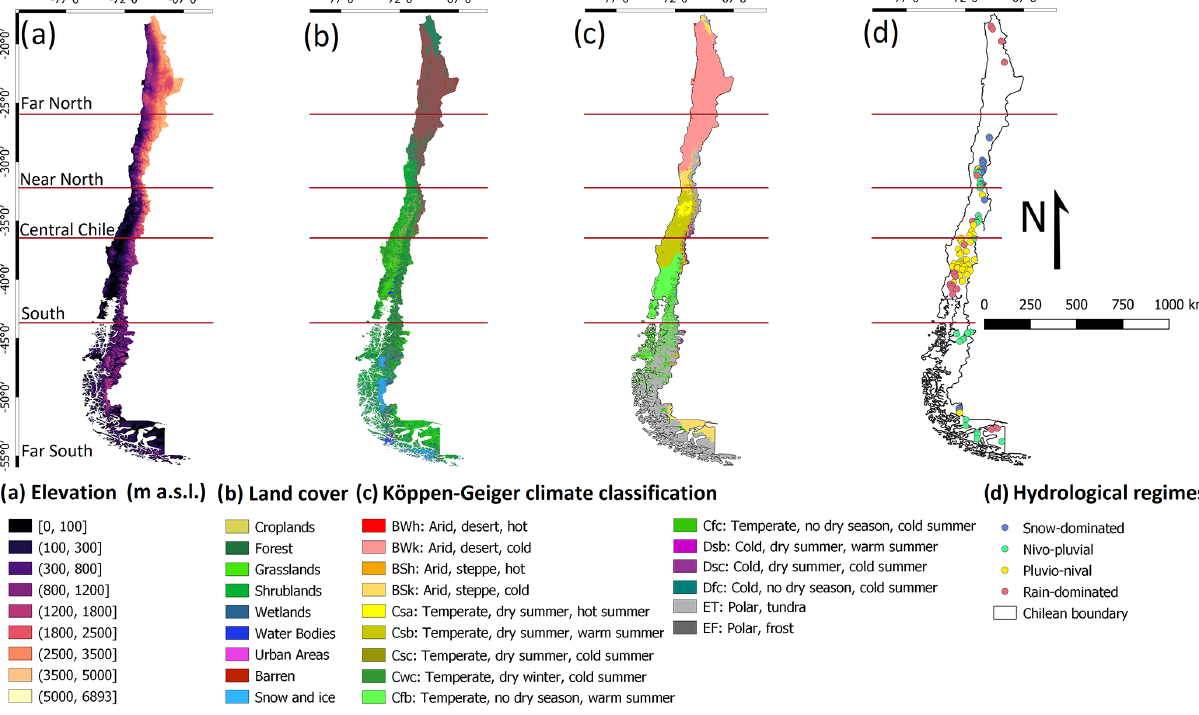
Figure 1. Study area: (a) elevation (SRTMv4.1; Jarvis et al., 2008); (b) land cover classification (Zhao et al., 2016); (c) Köppen–Geiger climate classification (Beck et al., 2018); and (d) hydrological regimes of the selected catchments over the five major macroclimatic zones according to Zambrano-Bigiarini et al.